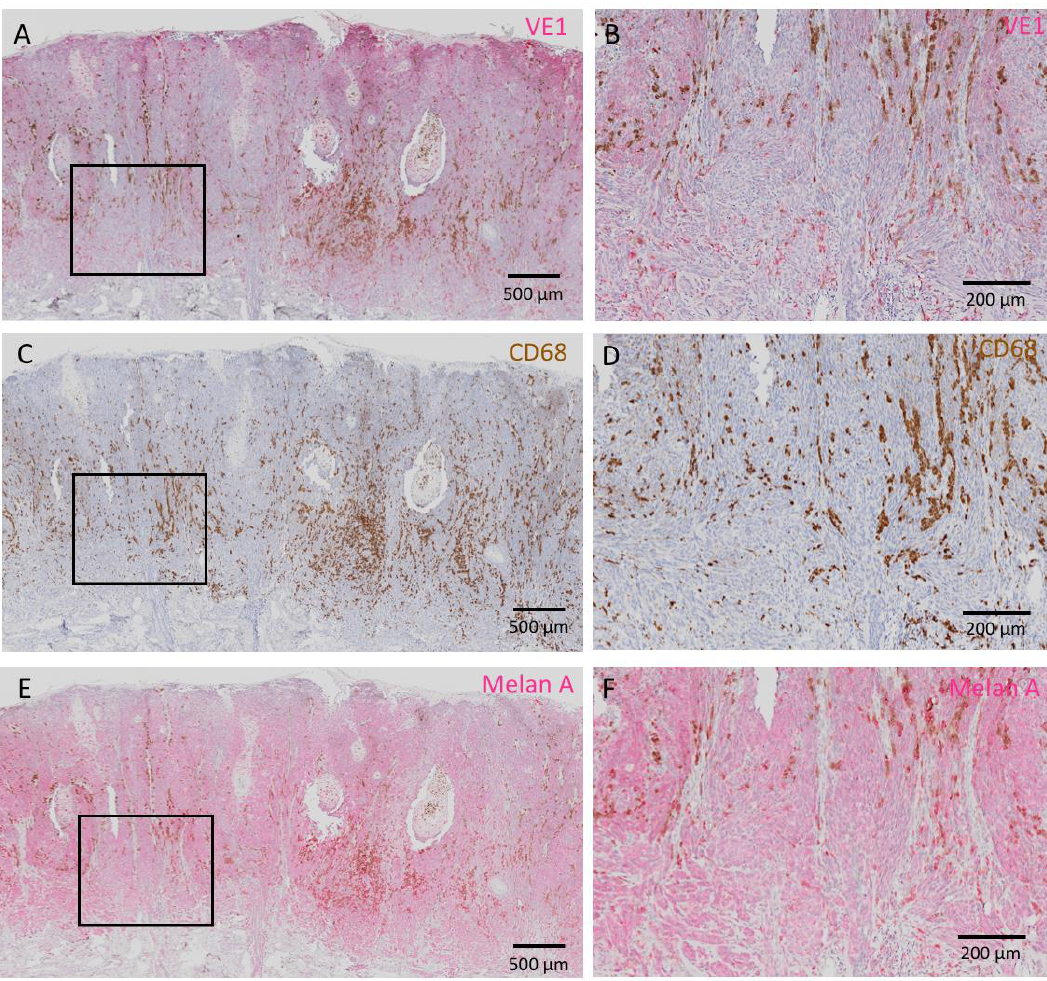
Figure 2 Figure 2. A case of acral melanoma with heterogeneous VE1 staining. VE1-positive signals are shown in red. ( A ) VE1-positive red melanoma cells and VE1-negative melanoma cells are intermingled. ( B ) High-powered view of the rectangular area in A . Cells with brown pigments and strongly red cells are scattered. ( C ) CD68 staining of the same area as in A . Positive signals of CD68 are shown in brown. ( D ) High-powered view of the rectangular area in C . Brown cells in D are tumor-infiltrating macrophages. ( E ) Melan A staining of the same area as in A and C . Positive signals are shown in red. ( F ) High-powered view of the rectangular area in E . Melan A staining clearly shows melanoma cells. Bars indicate 500 µ m in A , C , E , and 200 µ m in B , D , F